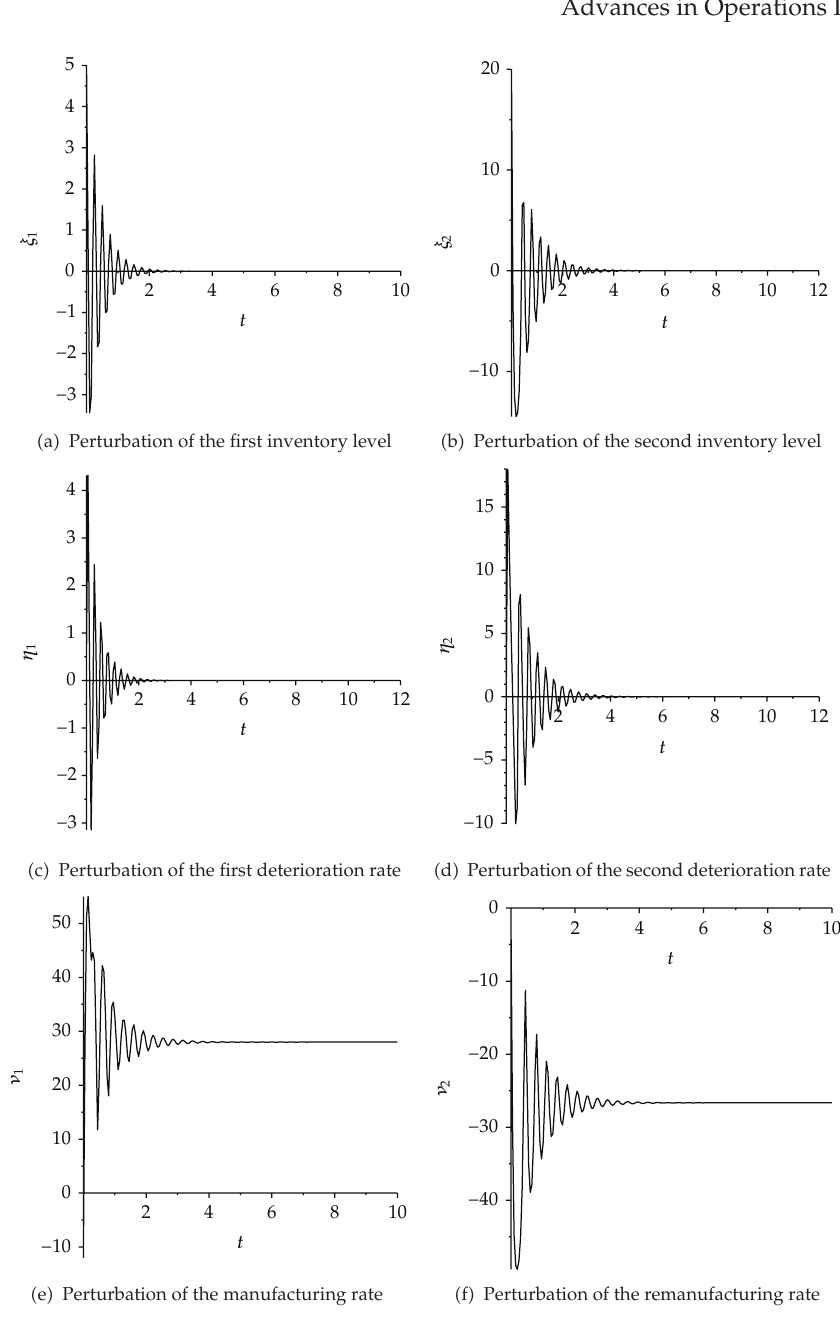
Figure 3: (cid:5) a (cid:6) : the perturbation of the first inventory level ξ 1 (cid:5) t (cid:6) , (cid:5) b (cid:6) : the perturbation of the second inventory level ξ 2 (cid:5) t (cid:6) , (cid:5) c (cid:6) : the perturbation of the first deterioration rate η 1 (cid:5) t (cid:6) , (cid:5) d (cid:6) : the perturbation of the second deterioration rate η 2 (cid:5) t (cid:6) , (cid:5) e (cid:6) : the perturbation of the manufacturing rate ν 1 (cid:5) t (cid:6) , and (cid:5) f (cid:6) : the perturbation of the remanufacturing rate ν 2 (cid:5) t (cid:6) , with the initial perturbations: ξ 1 (cid:5) 0 (cid:6) (cid:7) 5, ξ 2 (cid:5) 0 (cid:6) (cid:7) 20; η 1 (cid:5) 0 (cid:6) (cid:7) 0 . 2, η 2 (cid:5) 0 (cid:6) (cid:7) 0 . 3; ν (cid:5) 0 (cid:6) (cid:7) 5,